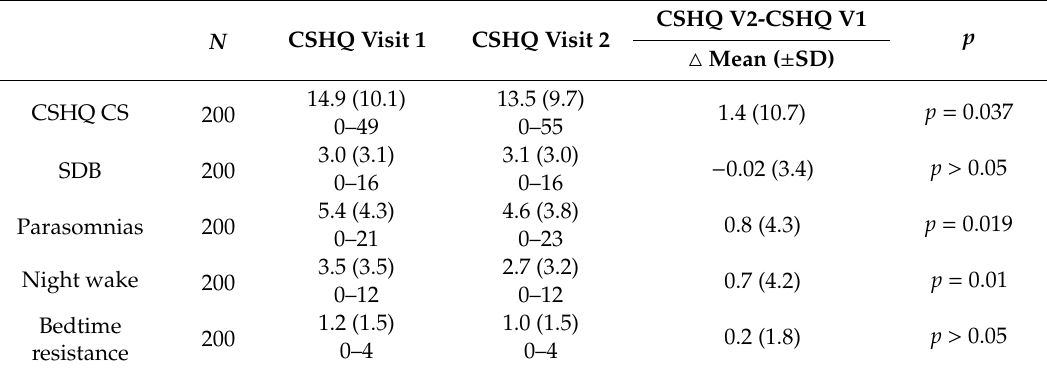
Table 4. Mean ( ± SD) and range for CSHQ Scores at visit 1 and